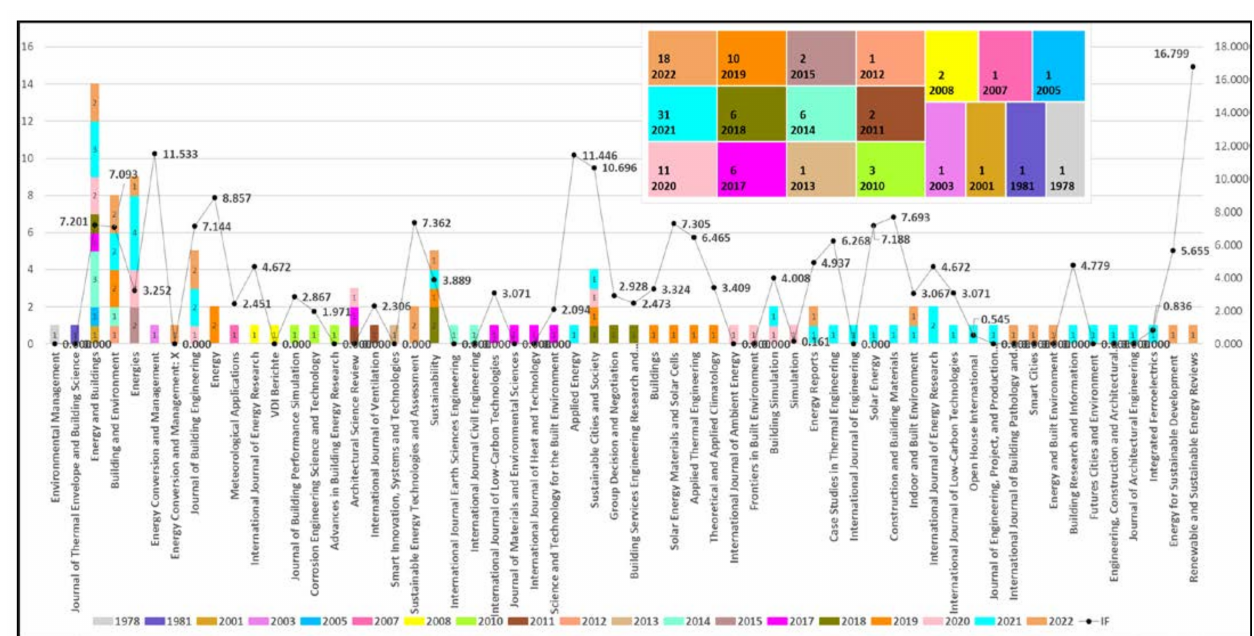
Figure 3. Results after applying PRISMA.